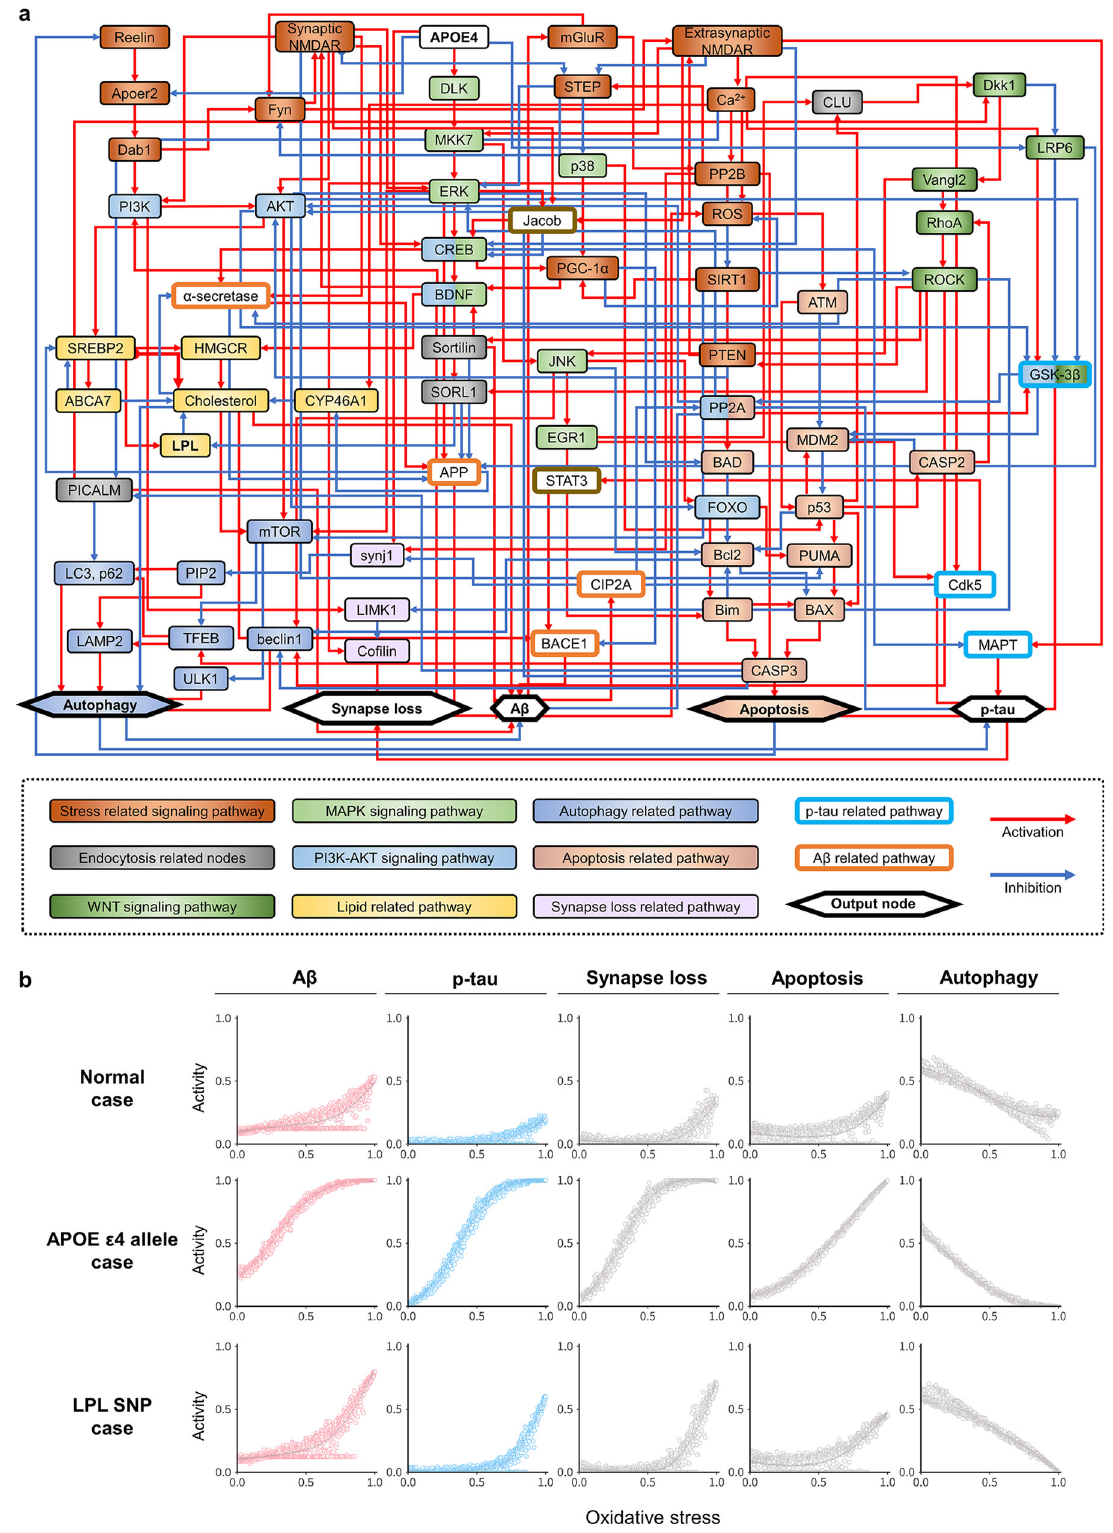
Fig. 4 The molecular regulatory network model of AD and its validation. a The molecular regulatory network model of AD was constructed with 77 nodes and 204 regulatory links. The colors of nodes indicate the corresponding KEGG pathways. b Simulation response pro fi les of the network models ( n = 5) to oxidative stress by varying oxidative stress (ROS) from 0% to 100% over one thousand ( n > 1000) independent simulations for each condition (normal, ApoE ɛ 4 allele (APOE4) case, LPL SNP case). Gray solid lines denote 95% con fi dence intervals around the mean value and each data-point means independent simulations (error band is so narrow and mostly not distinguishable from the line of mean value). A β beta-amyloid, p-tau phosphorylated tau, APOE apolipoprotein E, LPL lipoprotein lipase.